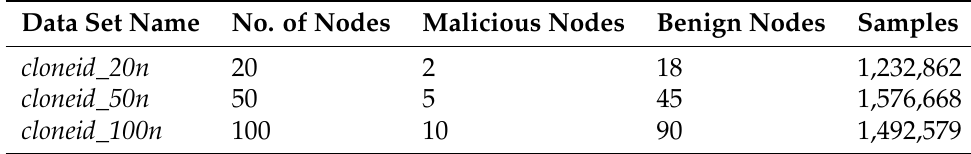
Table 5. Data set sizes and corresponding topologies.